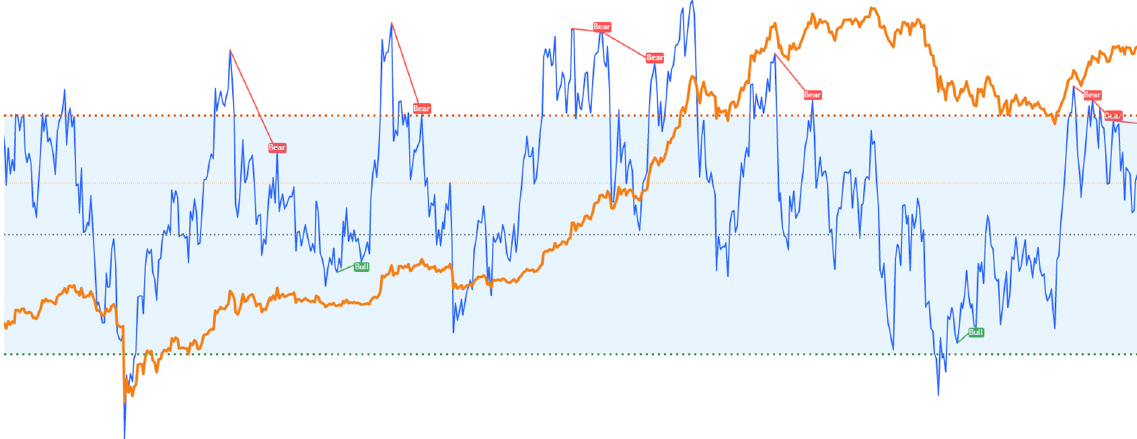
Figure 7. Example of the RSI Divergence, where blue stands for RSI value, orange stands for Bitcoin price, green stands for bullish divergences and red stands for bearish divergences.